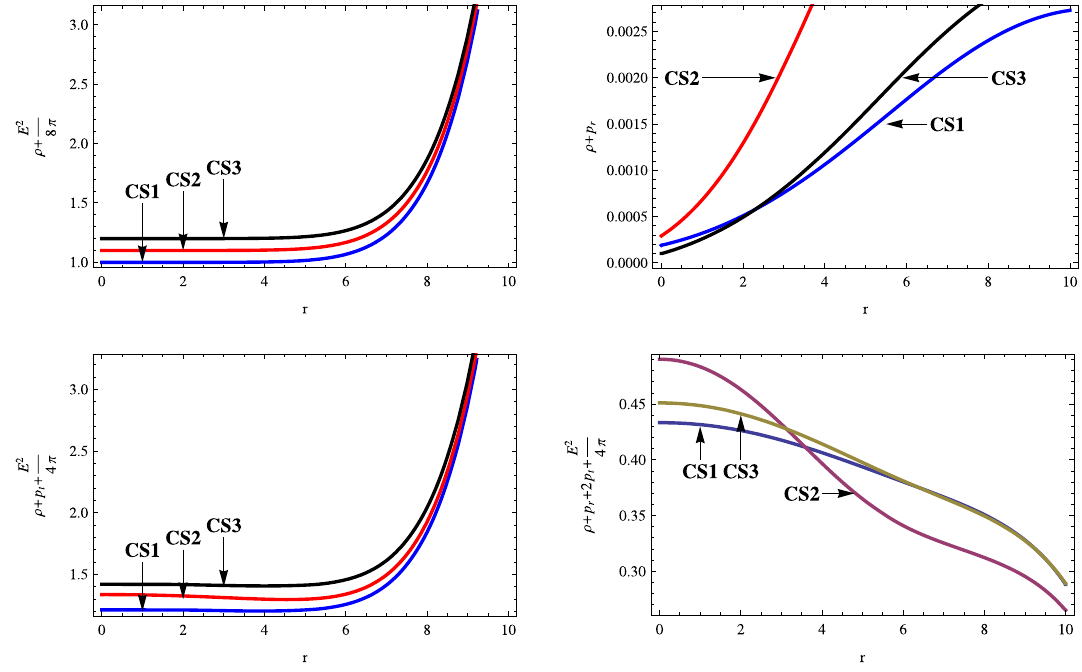
Fig. 12 Variations of energy conditions versus r (km) with the numerical values of A , B and C from Table